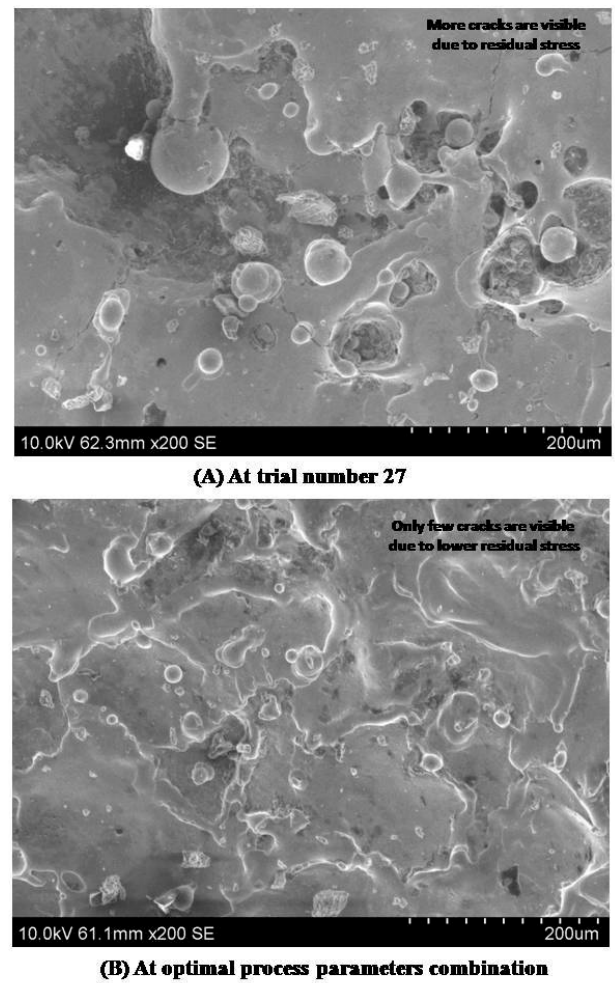
Figure 6. Comparison between surface morphology of machined specimens in WEDM process.